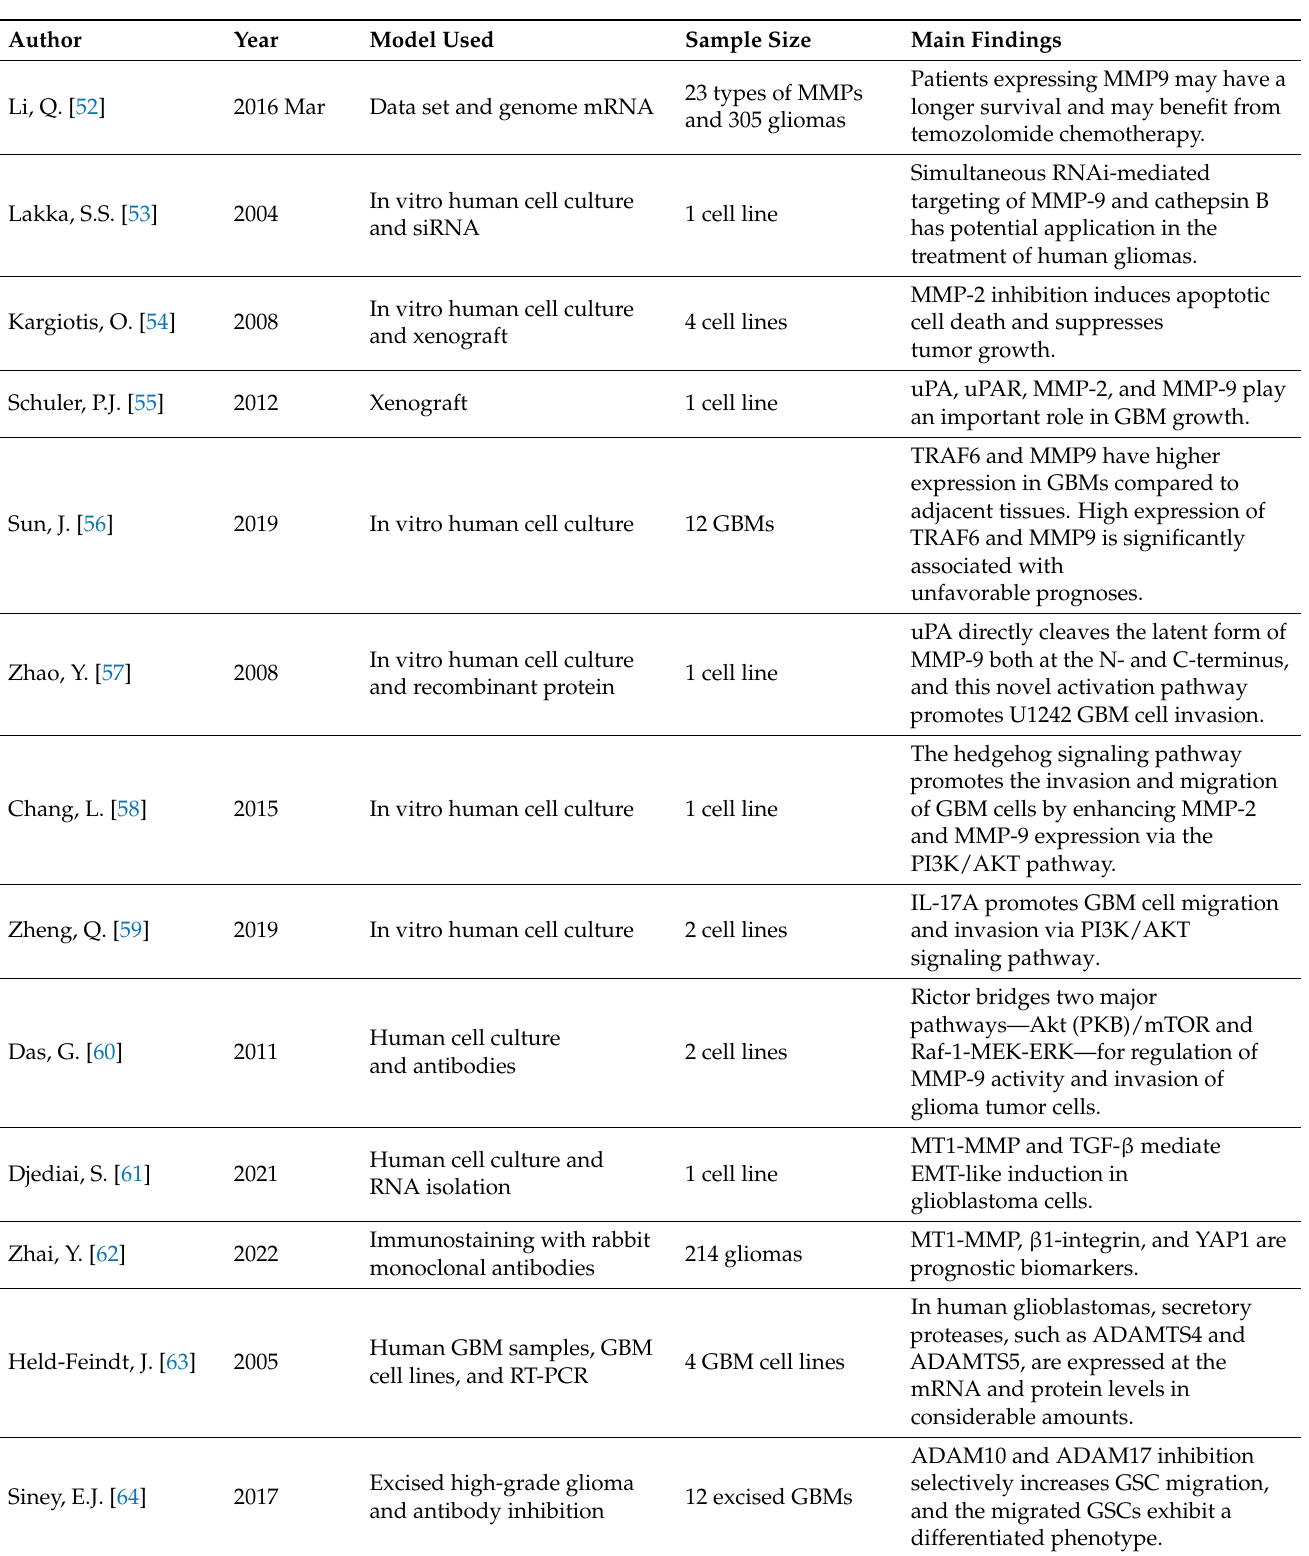
Table 5. Degradative